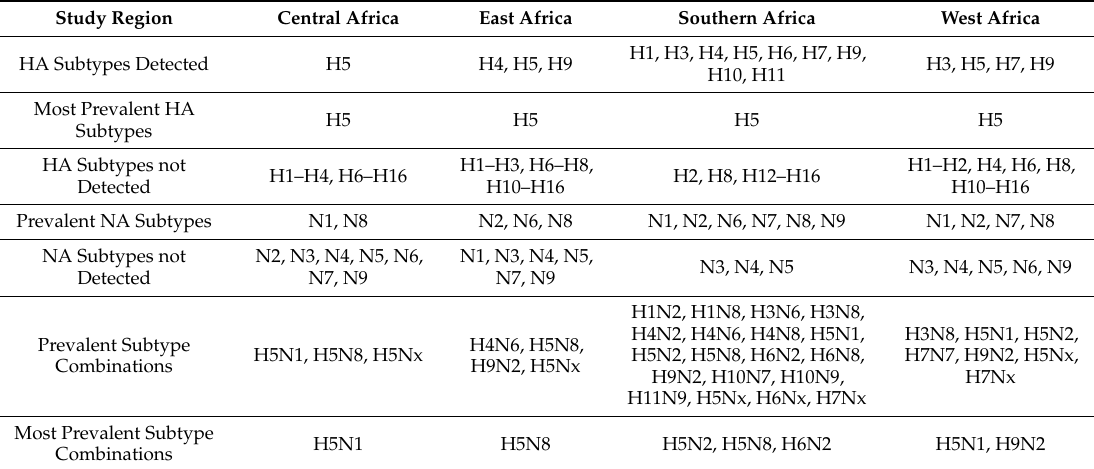
Table 4. AIV subtype detection in sub-Saharan Africa according to the included